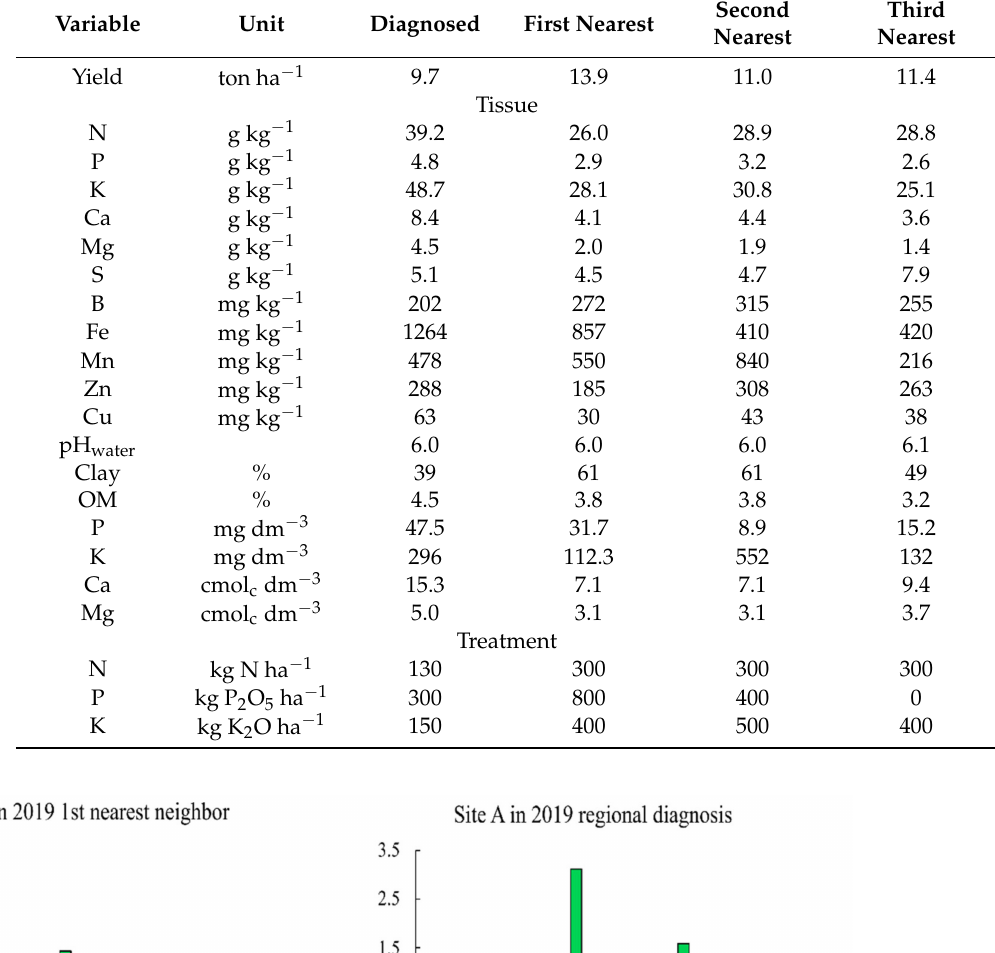
Table 6. Difference in yield and soil and tissue compositions in the diagnosed specimen at site A in 2019 and its closest nutritionally balanced neighbors yielding more than 11 ton ha − 1 .